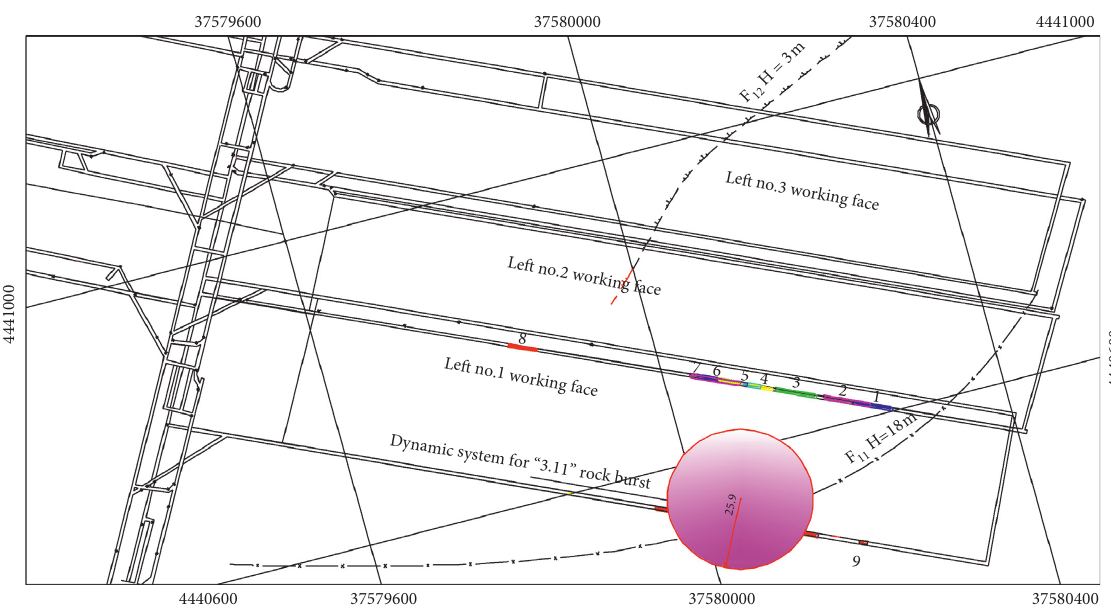
Figure 8: Dynamic system for “3.11” rock burst in Jixian Coal